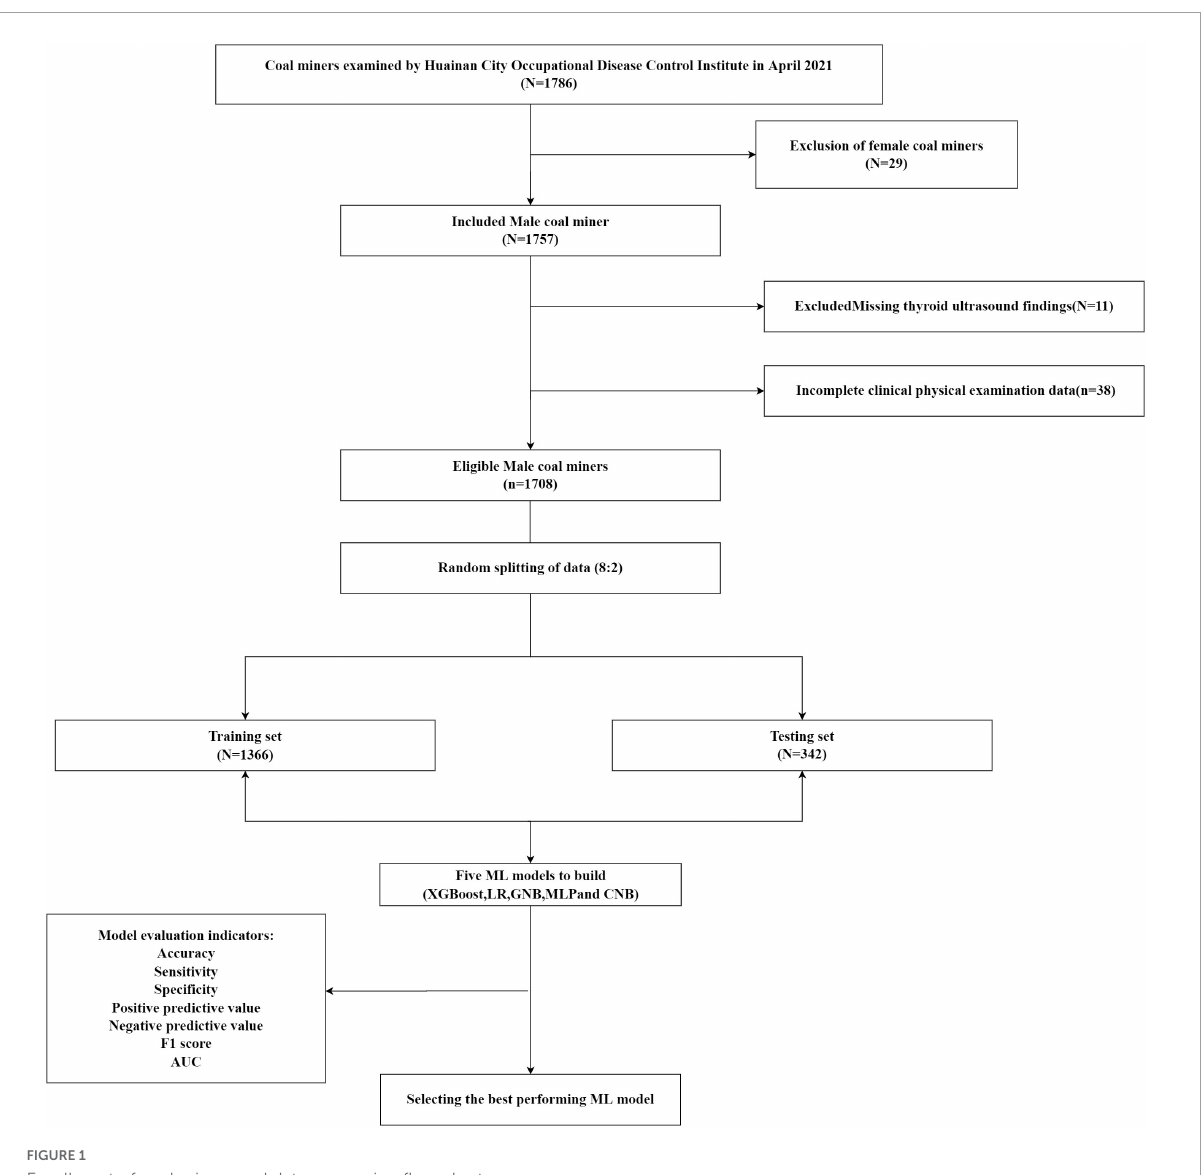
FIGURE1 Enrollment of coal miners and data processing flow